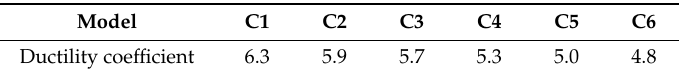
Figure 24. Force-displacement curves. Table 7. Ductility.